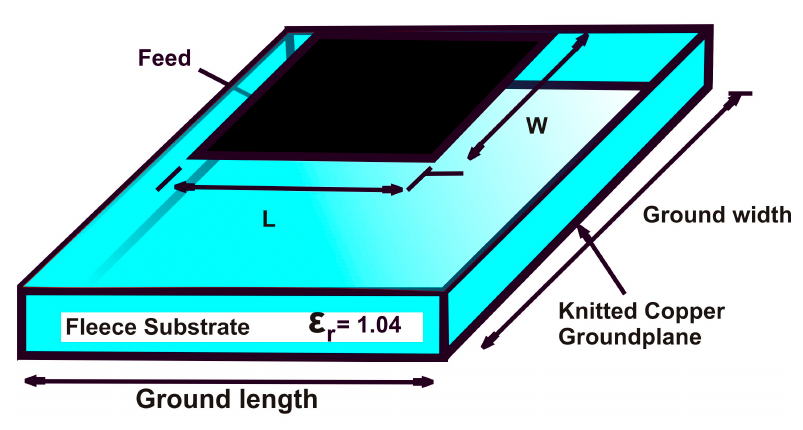
Figure 2. Geometry of the WLAN fabric antenna proposed in [7].